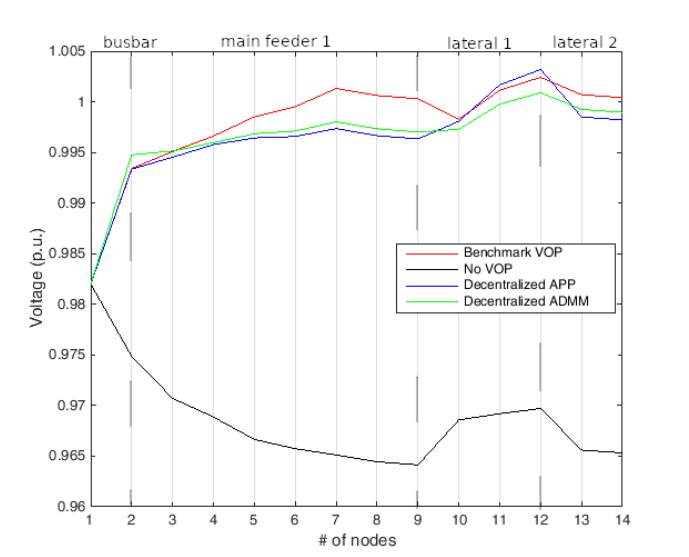
Figure 7. Voltage profiles along the main feeder 1 and the corresponding